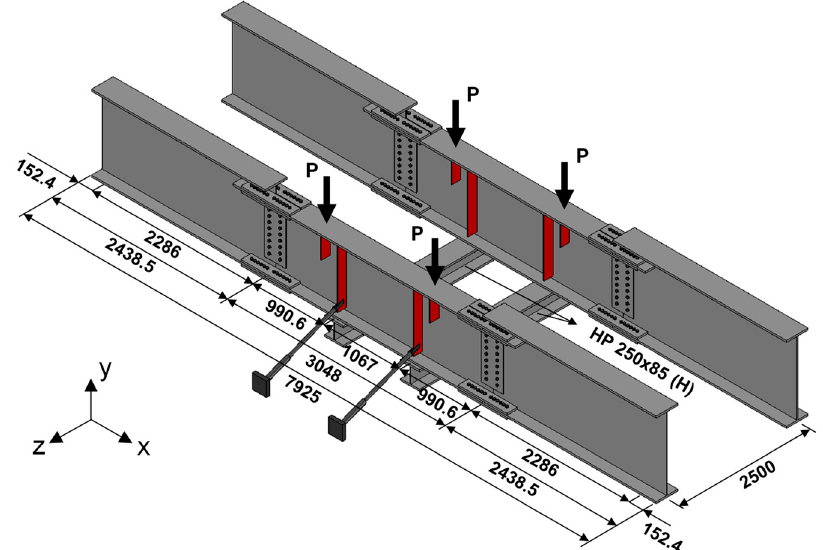
Figure 5. Global model of the structural system of beams; fatigue test of details sensitive to distortion-induced fatigue (units: millimetres).